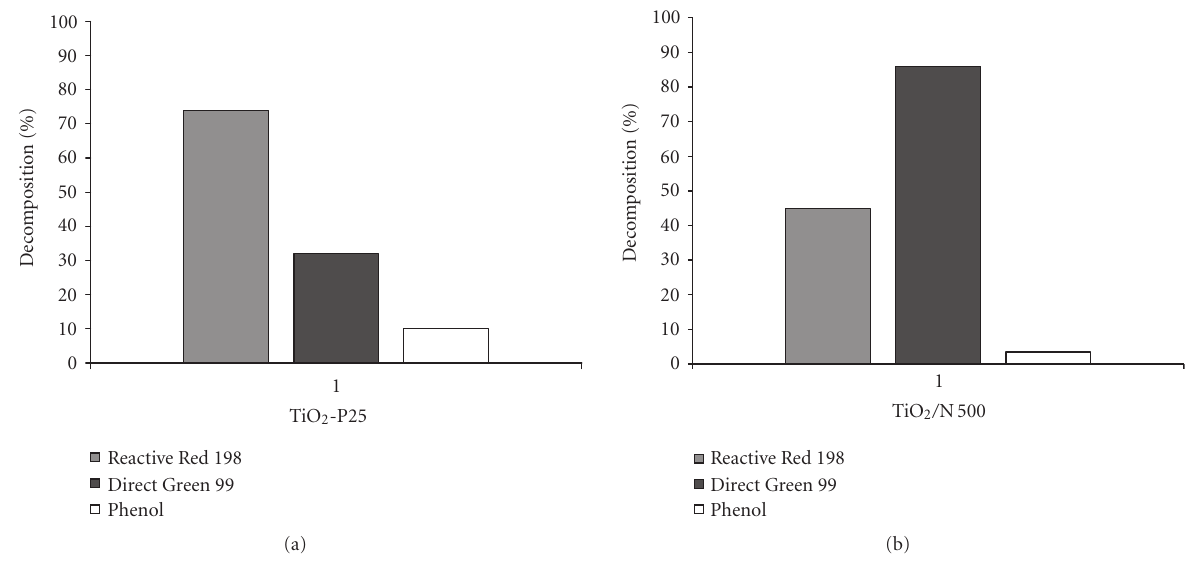
Figure 6: Photocatalytic decomposition of azo dyes and phenol under visible light in the slurry batch reactor (C 0ReactiveRed198 = 5mg/dm 3 , C 0DirectGreen99 = 10mg/dm 3 ; C 0phenol = 0,1g/dm 3 ; 0,2g TiO 2 /dm 3 ) on (a) TiO 2 -P25 and (b) TiO 2 /N 500.